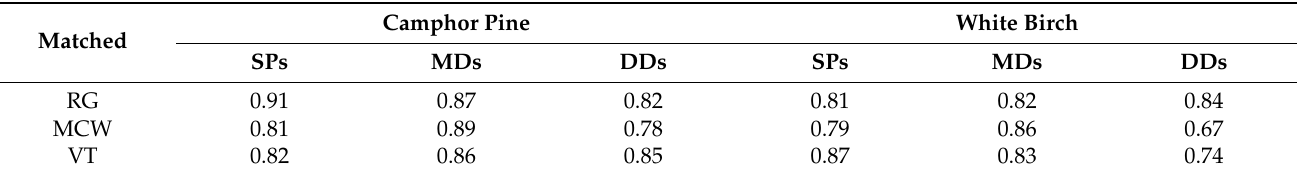
Figure 8. Frequency-distribution map of the ratio value of the delineated crown and the reference crown in various scenarios. Camphor pine_SP, Camphor pine_MD, and Camphor pine _DD refer to the sparse area, medium area, and dense area of camphor pine, respectively; White birch_SP, White birch_MD and White birch_DD refer to the sparse, medium, and dense areas of white birch. Orange, green, and purple lines refer to the tree-crown delineation using the methods of VT, RG, and MCW, respectively. Table 2. The matched conditions of tree-crown results obtained by different crown-contour algorithms with reference-crown results among various